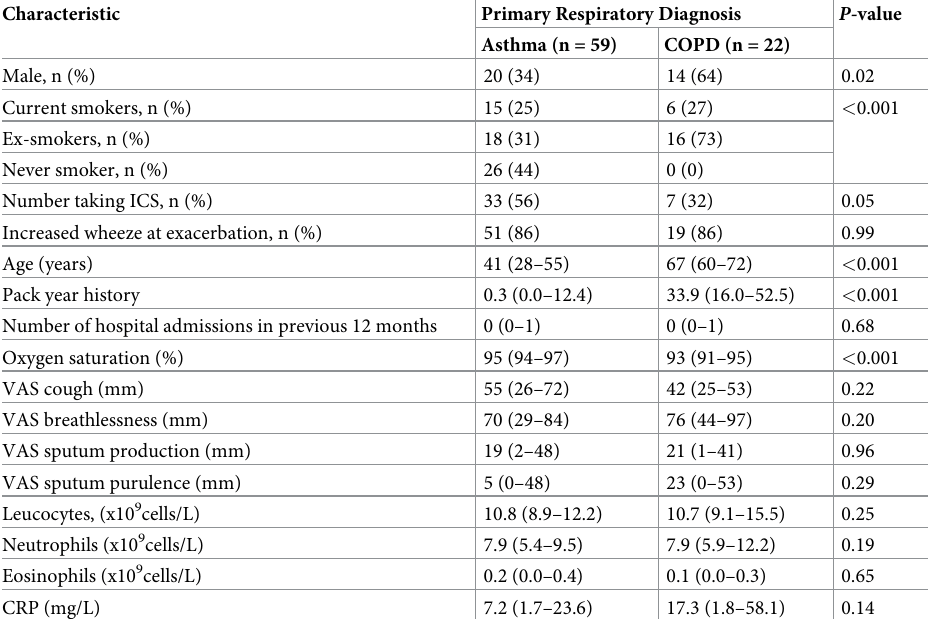
Table 1. Characteristics of the asthma and COPD participants at